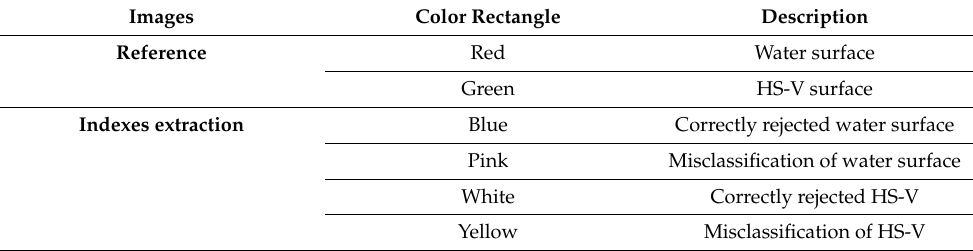
Table 7. Description of the colored rectangles used to analyze the non-binary snow cover extraction maps produced by the Snow-Cover Indices. The color rectangles in the color composite images indicate the reference surface to inspect, and rejection means a surface that the index algorithm has